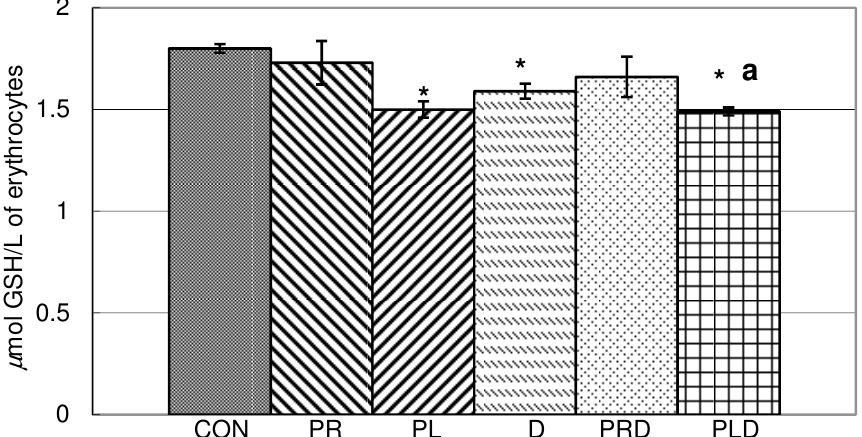
Figure 2. Content of reduced glutathione in blood hemolysate of animals treated doxorubicin, parsley leaves and roots juices and their combination. t-test, n =  6; compared to CON group: * p <0.05, compared to D group: a p